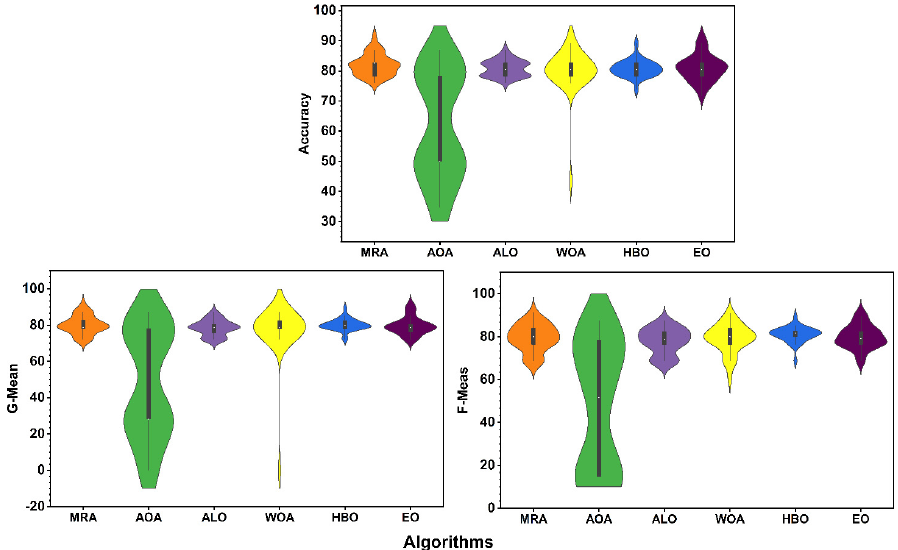
Figure 3. A violin plot illustrating a full performance distribution of classifiers.